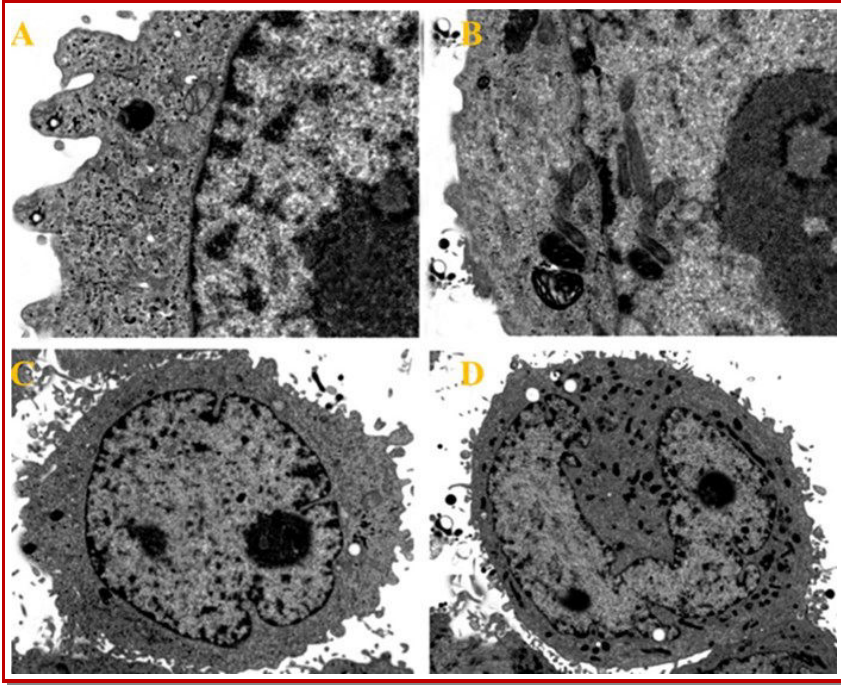
Figure 4: Study of the apoptotic cell death induced by caryophyllene oxide in MG-63 human osteosarcoma cells using transmis- sion electron microscopy. The cells were treated with 0 (A), 20 (B), 80 (C) and 120 (D) μ M dose of caryophyllene oxide and then observed under Transmission Electron Microscope at 10,000x